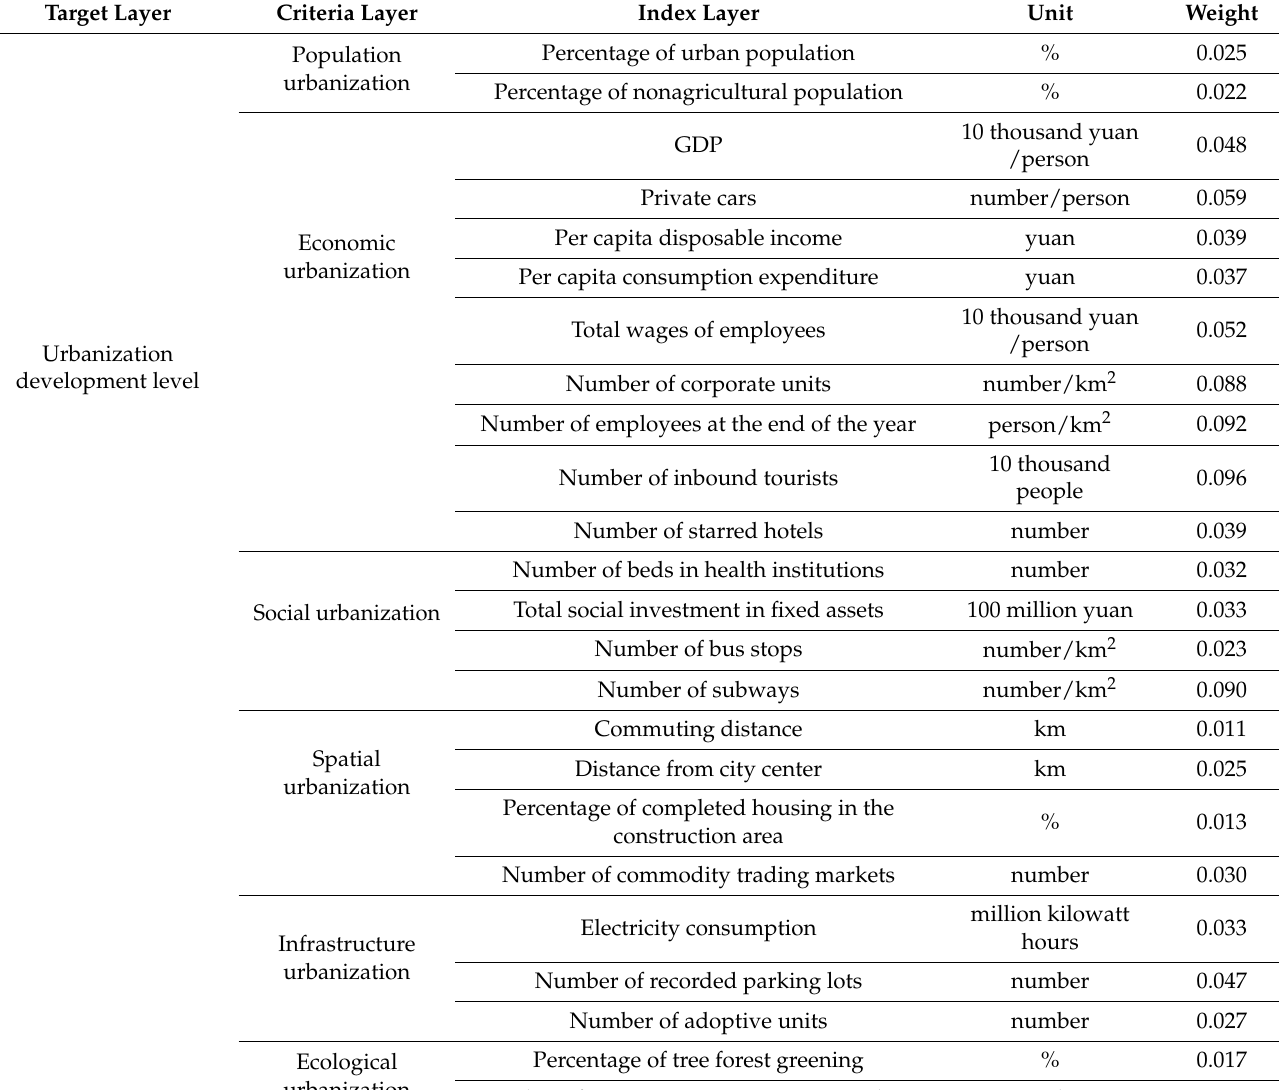
Table 2. Evaluation index system of urbanization development